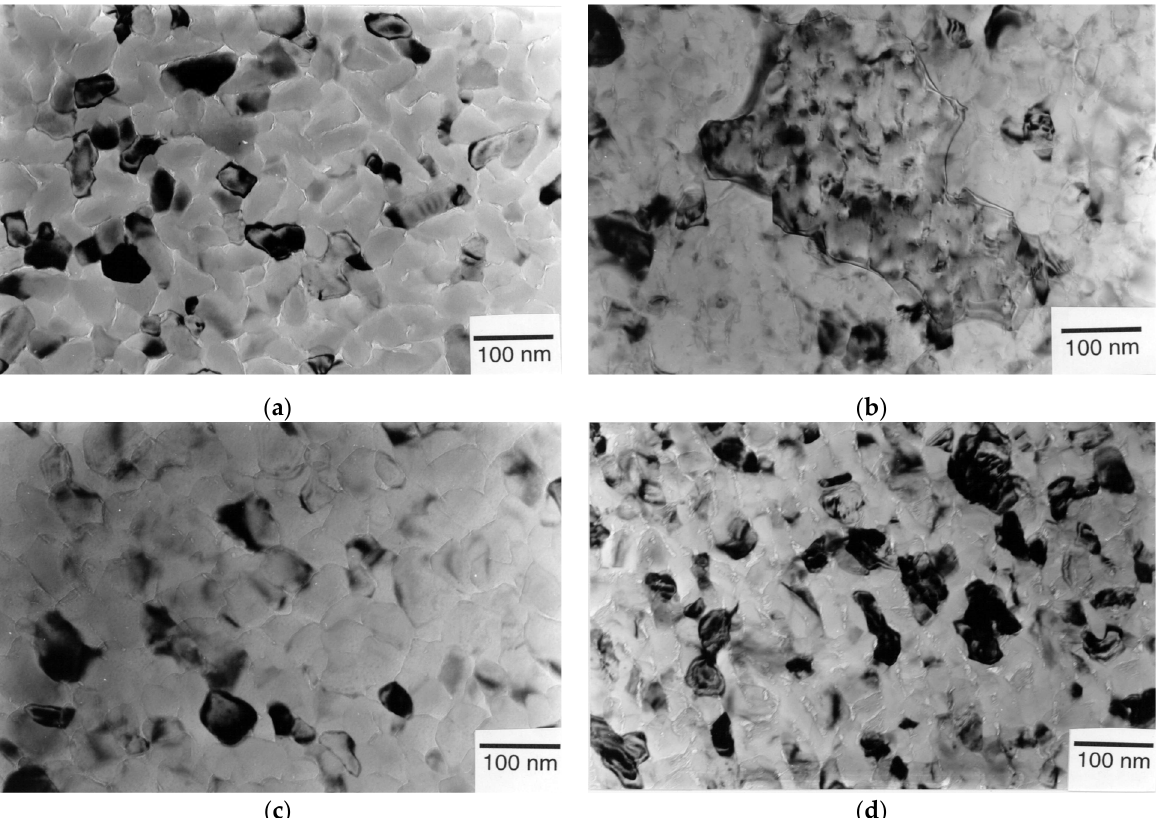
Figure 3. TEM micrographs of Al on polyimide. ( a ) Pristine; ( b ) O 2 plasma, 40 s; ( c ) O 2 plasma, 180 s; ( d ) Ar plasma, 180 s. ( d ) Ar plasma, 180